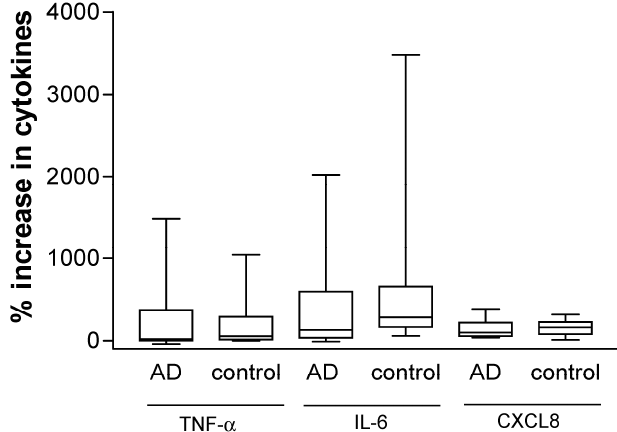
Figure 4. Ex vivo production of cytokines and chemokine from peripheral blood mononuclear cells (PBMC) of AD patients and control subjects upon NOD2 ligand MDP stimulation. PBMC (1 × 10 6 /mL) was incubated with or without NOD2 ligand MDP (1 μ g/mL) for 24 h at 37 °C. After incubation, the cell free supernatant of ex vivo culture was used for the assay of inflammatory TNF- α , IL-6 and CXCL8 using human inflammatory cytokine cytometric bead array (CBA) kit. The % increase of the cytokine induction by MDP was calculated by (concentration of cytokines stimulated by ligand − basal concentration of cytokines without any stimulation)/basal concentration of cytokine without any stimulation × 100%. Results are presented with Box and whiskers plot. AD: patients with atopic dermatitis; Control: normal control subjects.